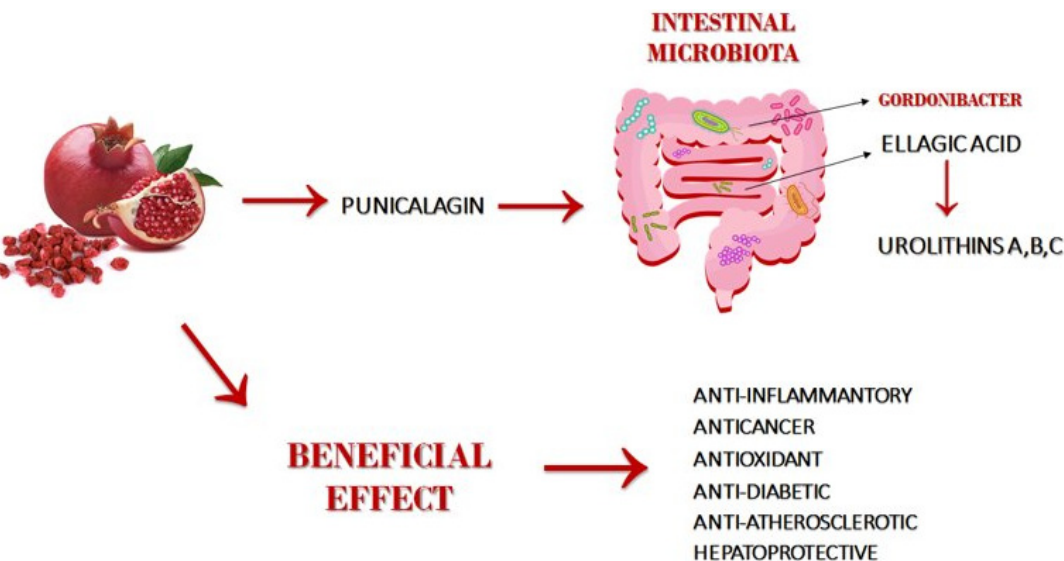
Figure 1. Metabolism of punicalagin and its beneficial effects.